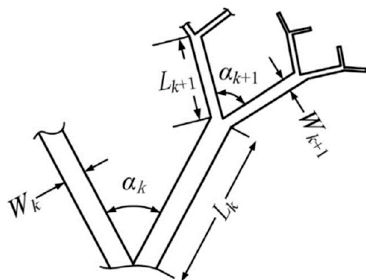
Figure 9. Four-level dendritic fins [77]. (Permission to reproduce from Ref. [77]).